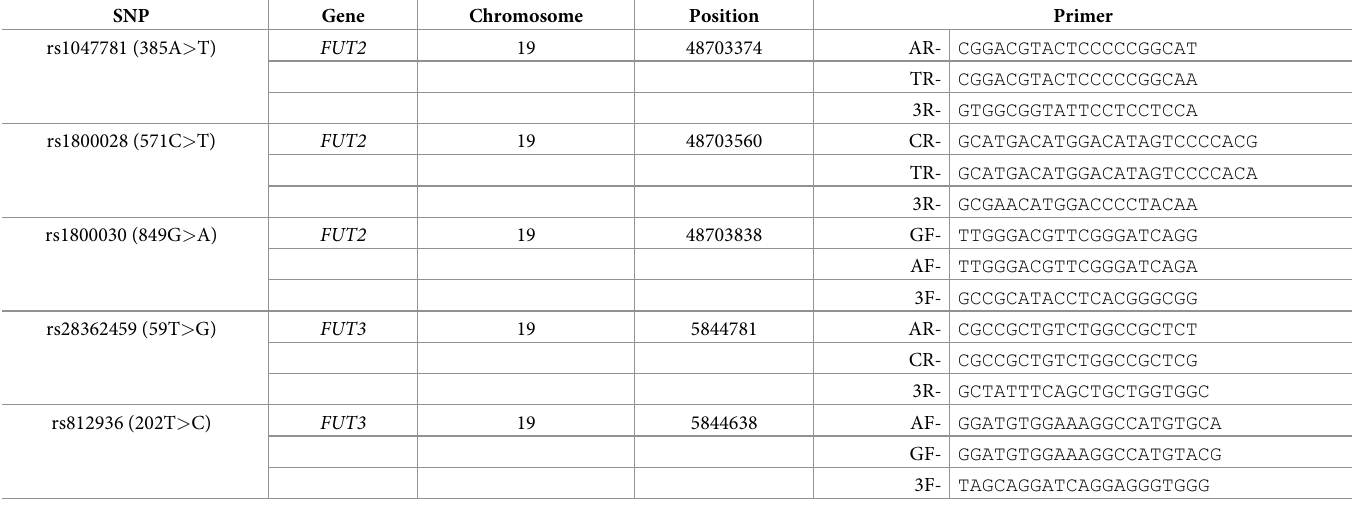
Table 1. SNP information and primer sequences used for genotyping. SNP